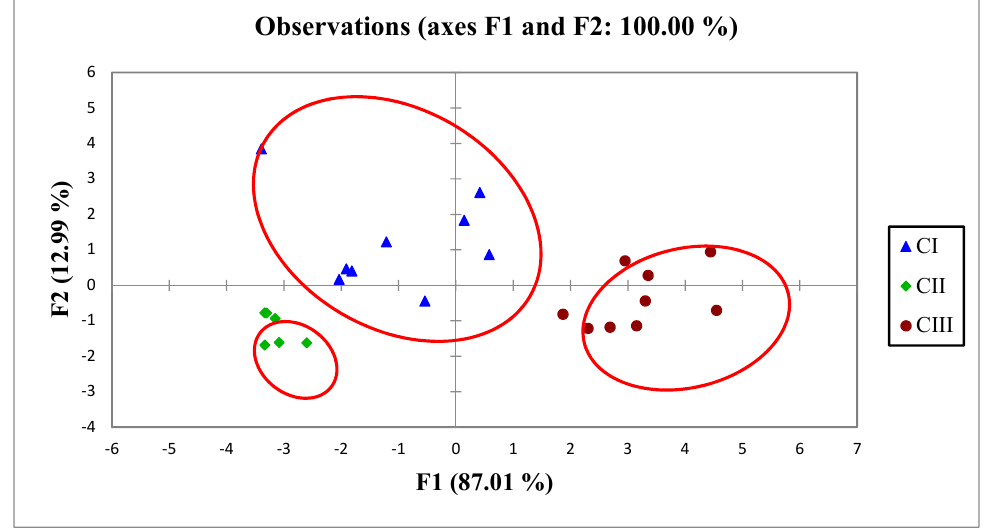
Figure 5. Discriminant analysis of the sampling groups.